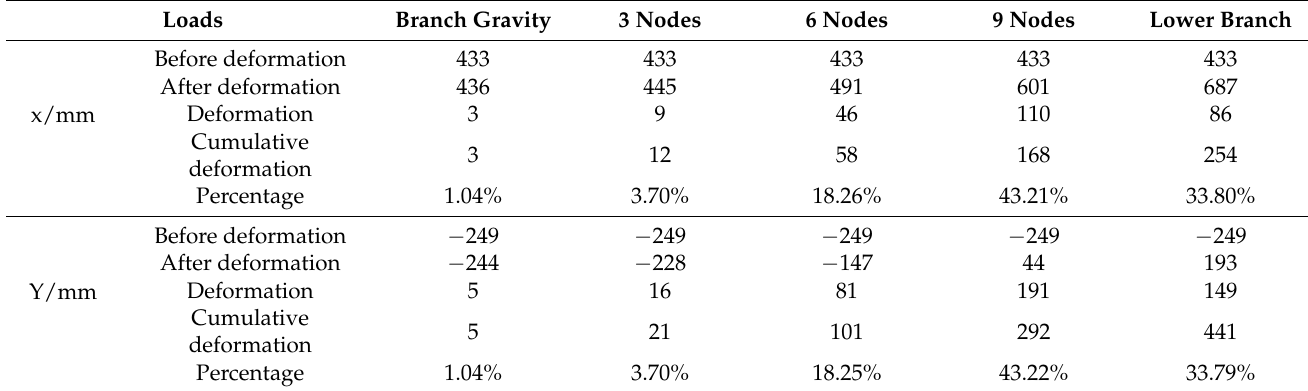
Table 5. Result of